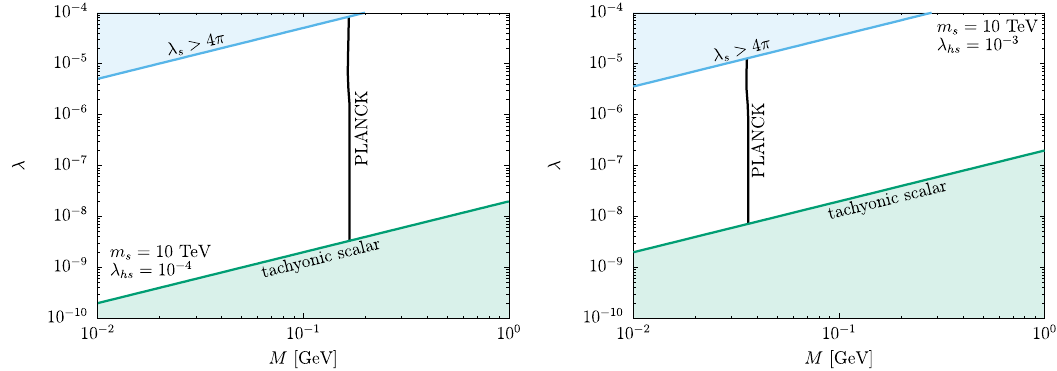
Figure 9 . (cid:21) vs M producing the correct relic DM relic density (\PLANCK") for a heavy s . The dominant DM production mode is h ! (cid:23)(cid:23) . The maximal temperature is chosen to be T 0 = 1 TeV. (cid:21)(cid:18) which is (cid:12)xed for a (cid:12)xed M . This makes the production rate independent of (cid:21) and the PLANCK region vertical in the ( M; (cid:21) ) plane. As before, our DM is under-abundant to the left of the PLANCK